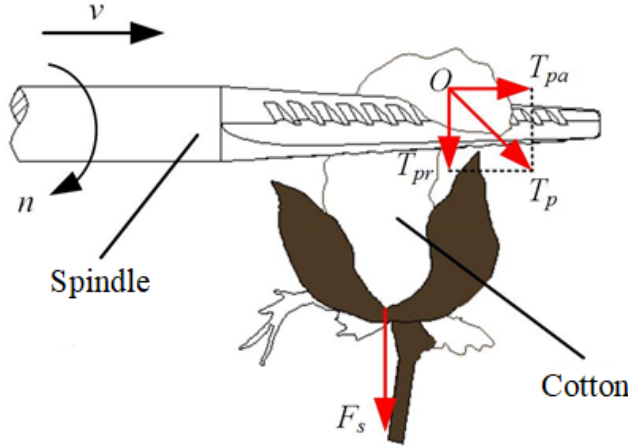
Figure 2. Schematic representation of the spindle picking process.